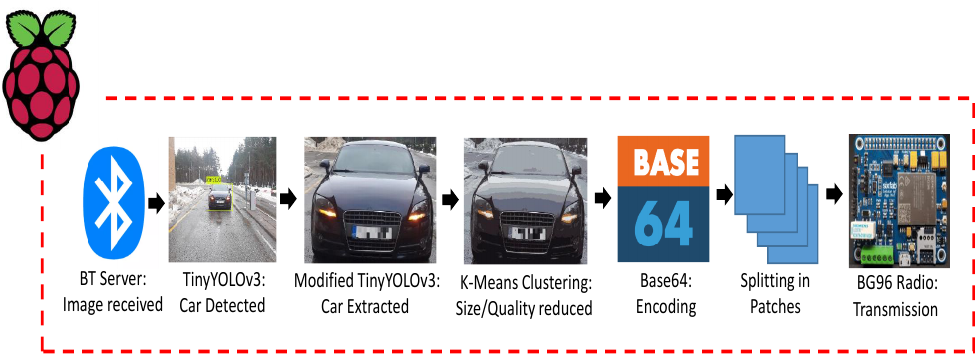
Figure 7. Smart transmit